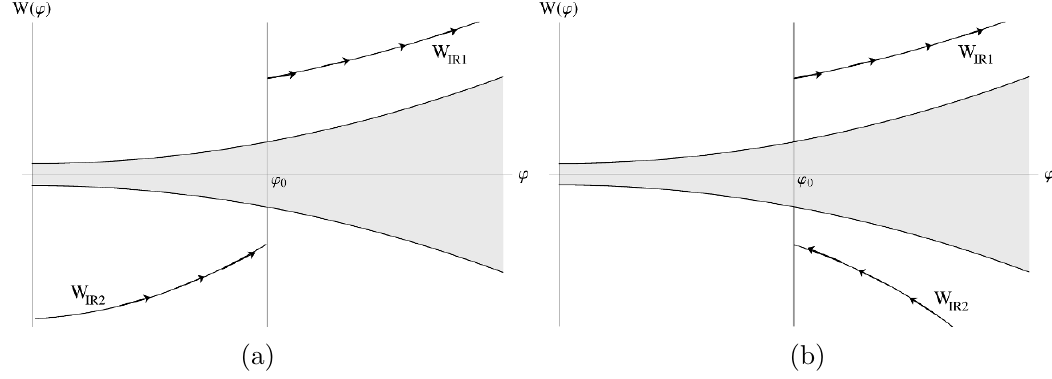
Figure 18 . The behavior of the superpotential in case B, when W IR ( ’ 0 ) (cid:0) W B ( ’ 0 ) < (cid:0) B ( ’ 0 ). Contrary to cases A1 and A2, in this case the solution does not connect to the UV on either side of the interface. Rather, the interface joins two \IR" (i.e. (cid:12)nite-volume) regions (hence both branches are labeled IR in the (cid:12)gures). Without (cid:12)ne tuning, at least one of them will have an unacceptable